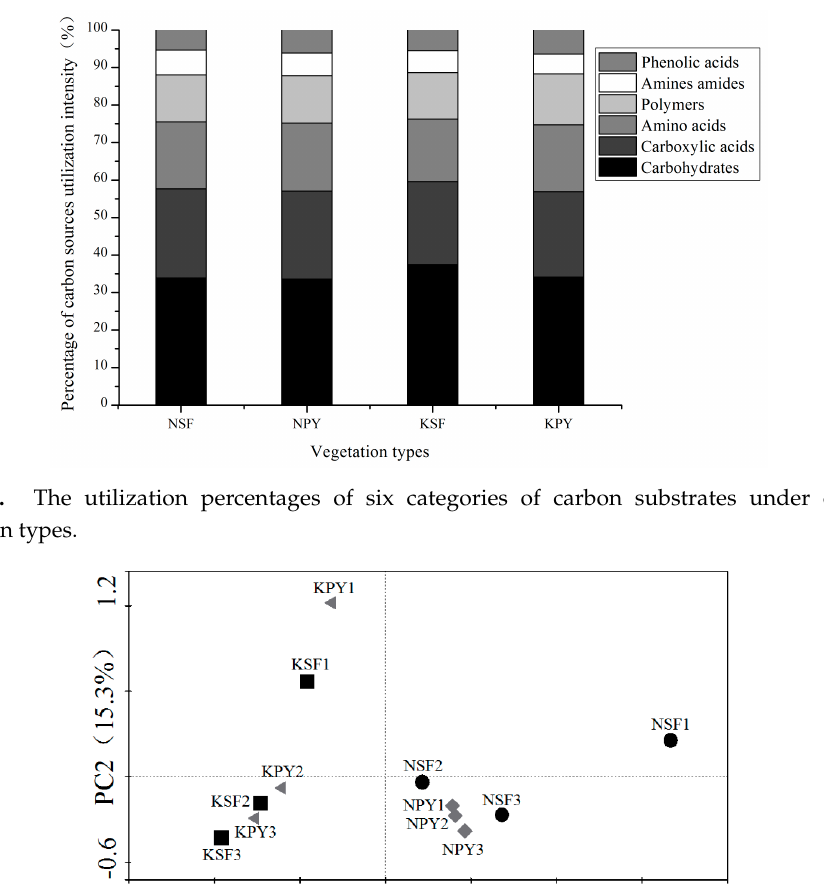
Table 4. Eigenvalues and cumulative variances of the redundancy analysis ordination of the soil microbial